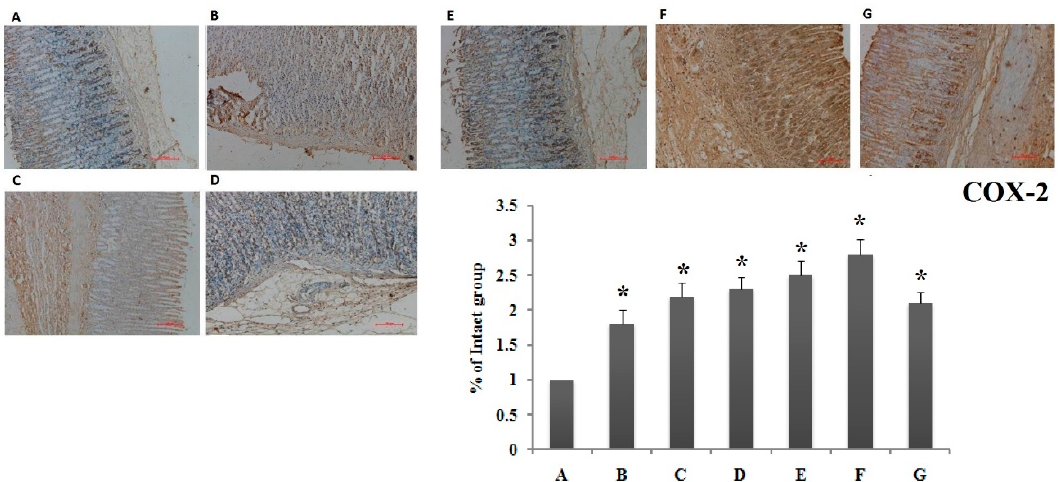
Figure 4. Immunohistochemistry results showing the effect of compound LSZ capsule on the expression of VEGF and COX ‐ 2 ( n = 6). A , Intact; B , Model; C , reference product of 30 ‐ mg enteric ‐ coated capsules of LSZ (2.7 mg/kg); D , LSZ (2.7 mg/kg); E , F , G , test product of 30 ‐ mg capsules of compound LSZ (LSZ:NaHCO 3 ): (1.35 mg/49 mg), (2.7 mg/99 mg) and (5.4 mg/198 mg) for compound LSZ ‐ L, compound LSZ ‐ M and compound LSZ ‐ H groups, respectively. * p < 0.05 compared with intact group.